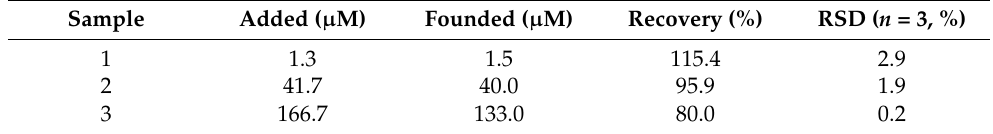
Table 3. Determination of Cu 2+ in tap water based on the AChE-like activity of ZIF-8. Sample